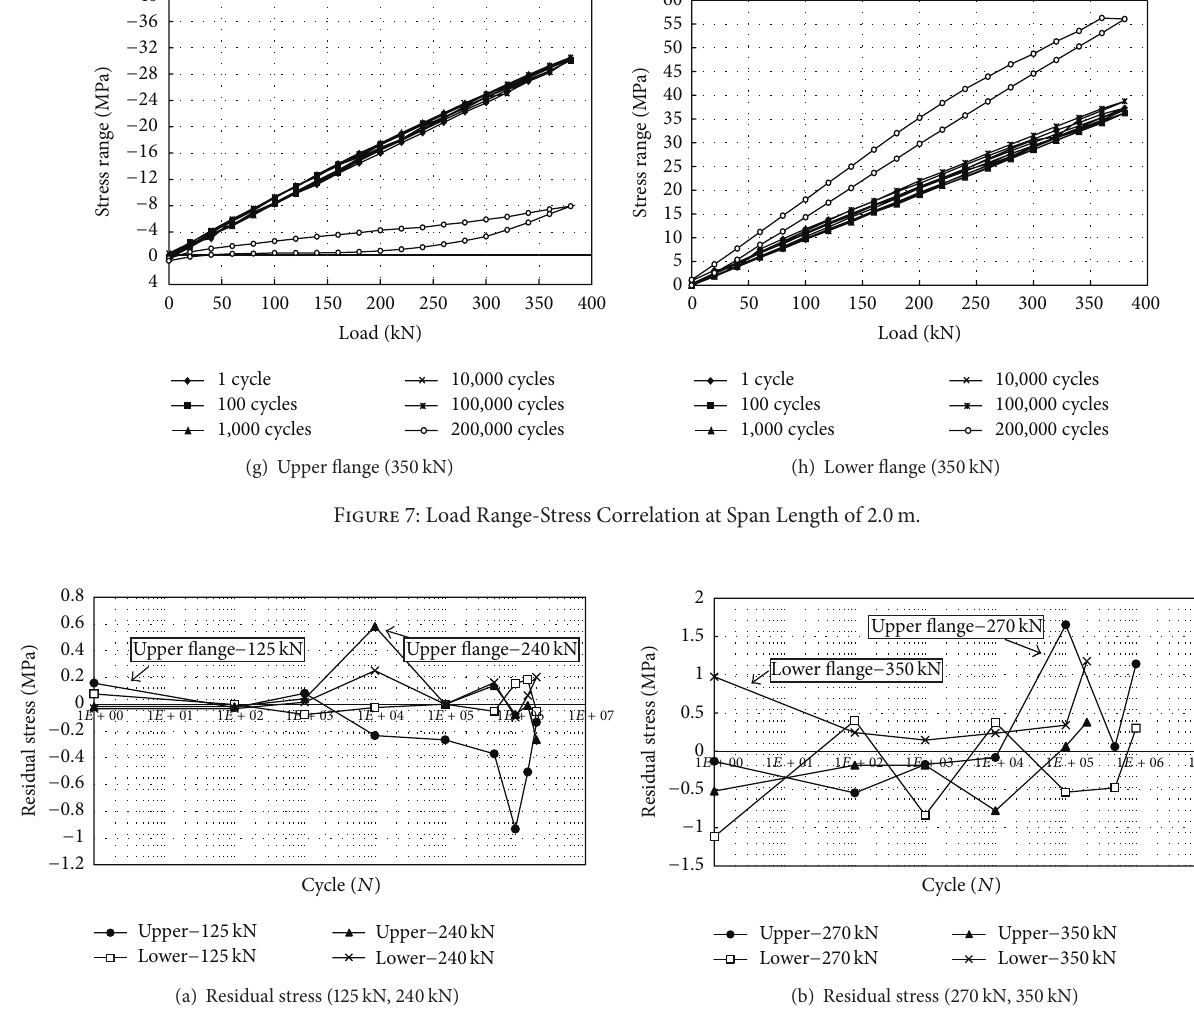
Figure 8: Load range-residual stress correlation at span length of